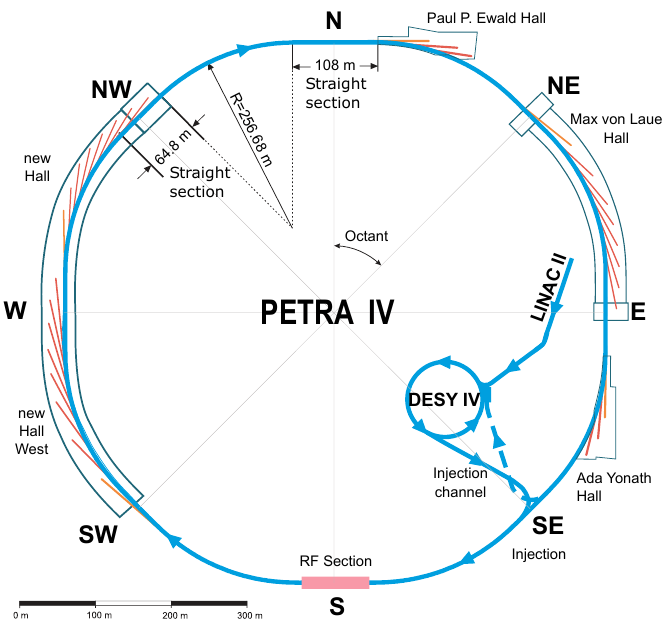
Figure 1. PETRA IV layout including the inear accelerator INAC II, the booster ring DESY IV, and different experimental halls (reprinted from [11] with permission from